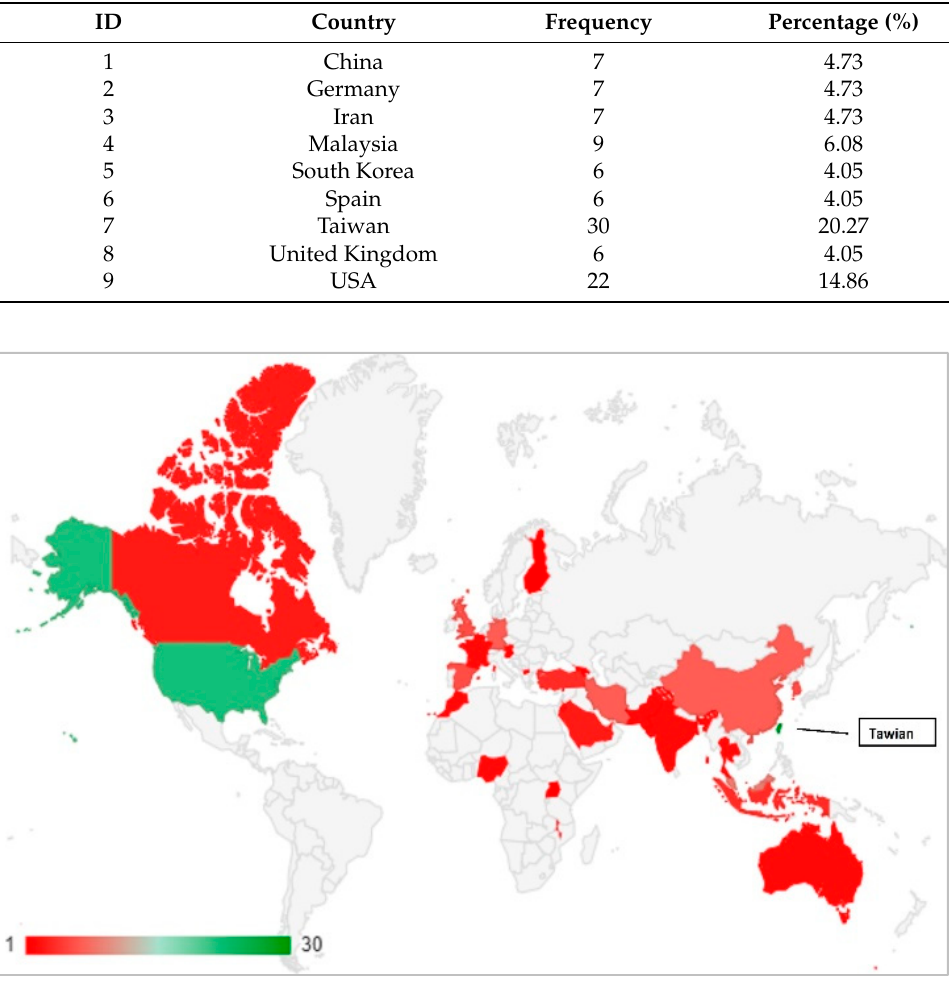
Figure 8. Geographic chart for the studies included in this review. Table 5. Technology types and directions of countries.